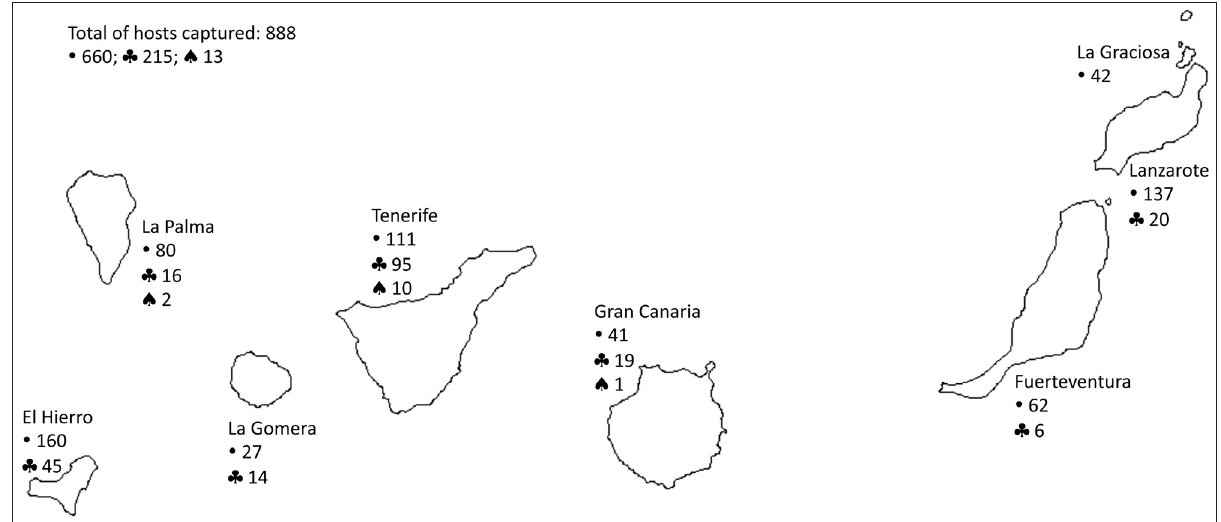
Fig. 1. – Host distribution in each Island of the Archipelago. ● Mus musculus ;  Rattus rattus ;  Rattus norvegicus